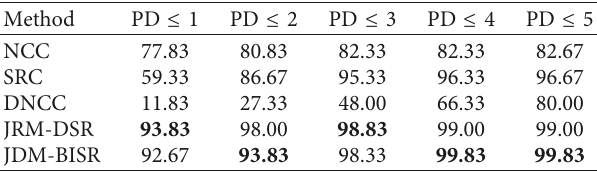
Table 10: Image matching results comparison in terms of scale variation, where the size of the blurry input image is 60 ×